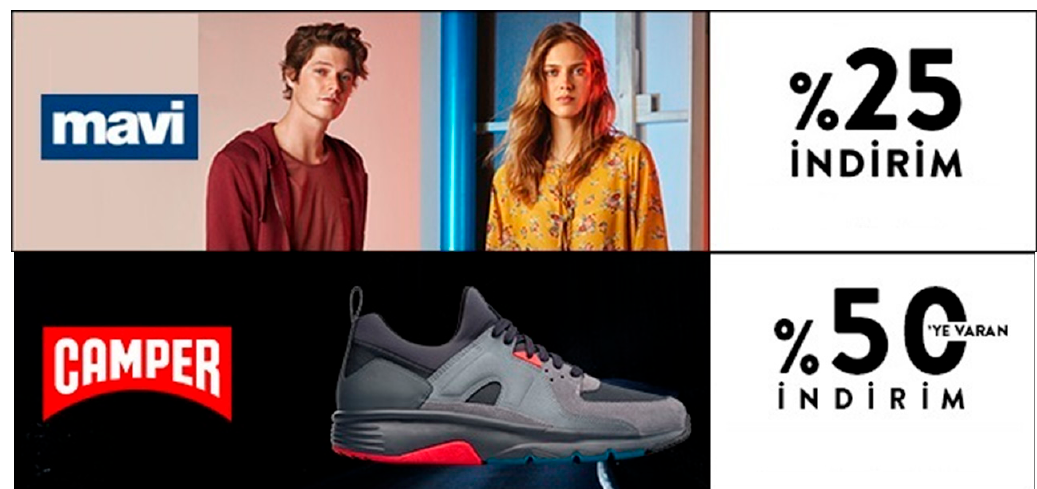
Future Internet 2021 , 13 , x FOR PEER REVIEW Figure A2. The banner ads numbered 2a ( above ) and 2b ( below ). Figure A2. The banner ads numbered 2a ( above ) and 2b ( below ).